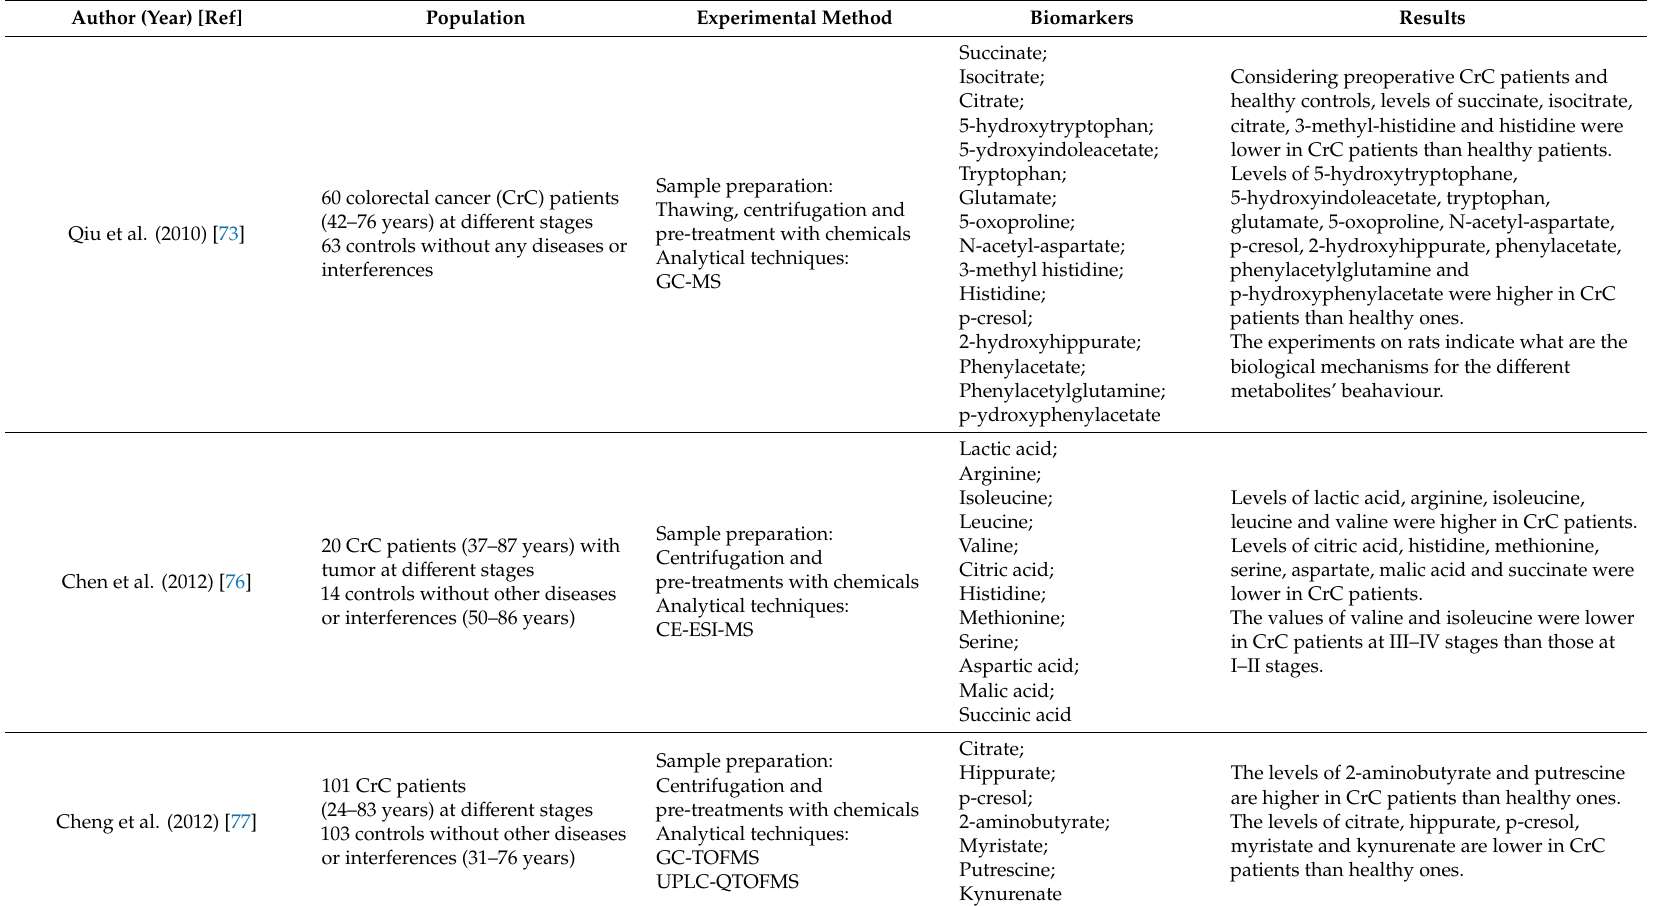
Table 4. Literary studies investigating urinary colorectal cancer